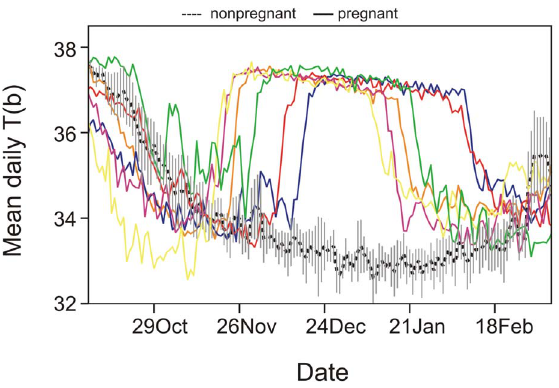
Figure 1. Mean daily body temperature (T(b)) of pregnant (N=6) and nonpregnant (N=9) hibernating female brown bears in Sweden, during 2010–2013. The solid lines show the mean daily T(b) of 6 individual pregnant females, the dotted line shows the mean daily T(b) of 9 nonpregnant females, including the daily SE (gray bars). The T(b) decreased throughout gestation (Estimate= 2 0.002, SE , 0.001, P , 0.001).